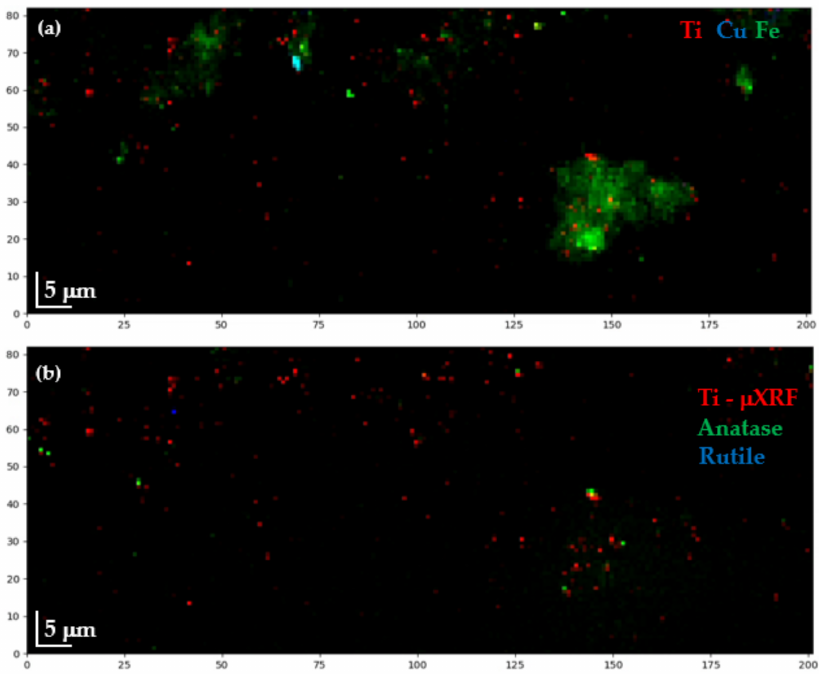
Figure A6. Results from the µ XRD analysis; ( a ) RGB µ XRF map of total Ti, Cu and Fe distribution in a CNS water extract sample. ( b ) RGB µ XRF map of total Ti distribution overlapped with the distribution maps of diffraction signals corresponding to anatase and